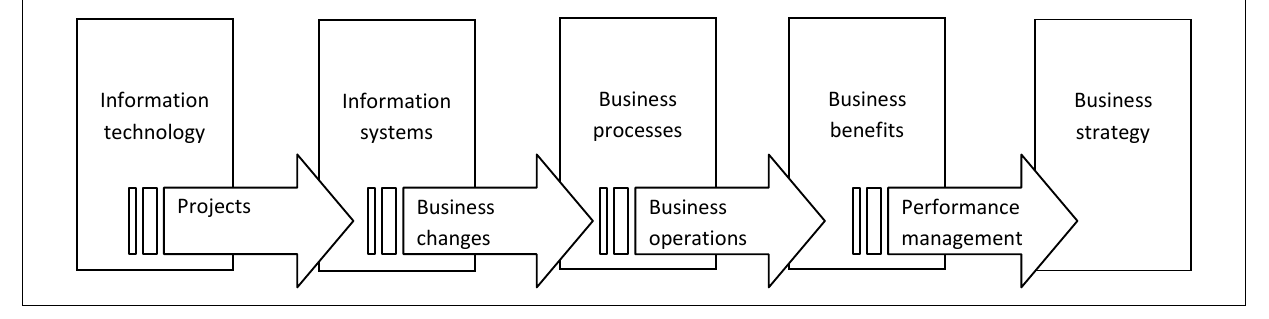
FIGURE 1 IMBOK Framework (from Bytheway